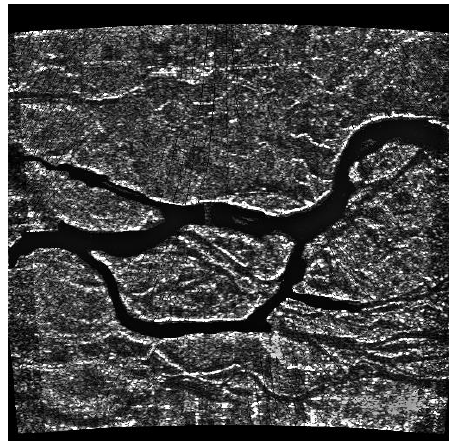
Fig. 2. Radar image of the earth’s surface after non -linear